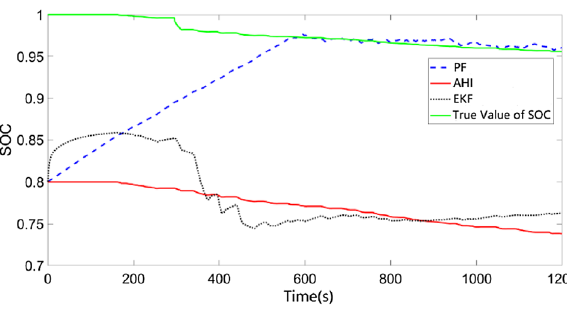
Fig. 3 Comparison of estimated values with initial SOC value of 0.8